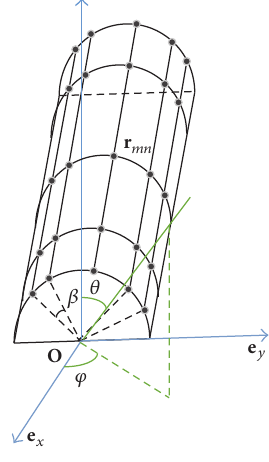
Figure 4: The cylindrical conformal array consisting of 𝑀×𝑁 short